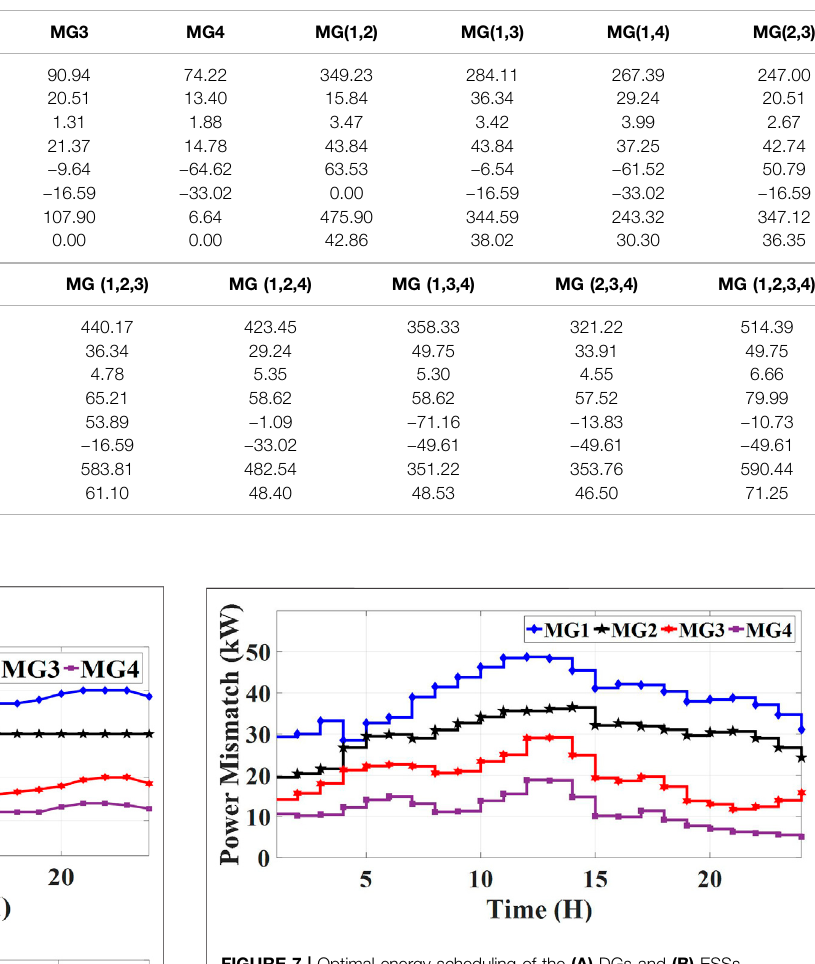
FIGURE 7 | Optimal energy scheduling of the (A) DGs and (B)